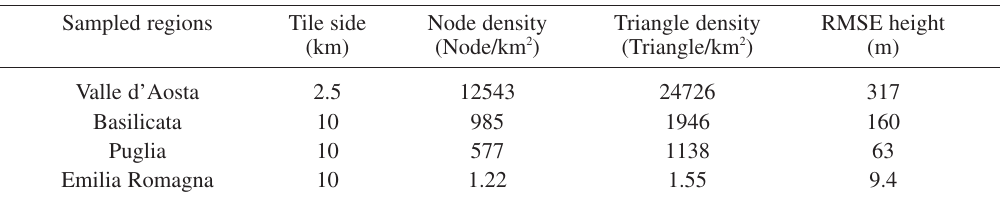
Table IV. Characteristics for the four cases presented in fig. 9a-d. Sampled regions Tile side Node density Triangle